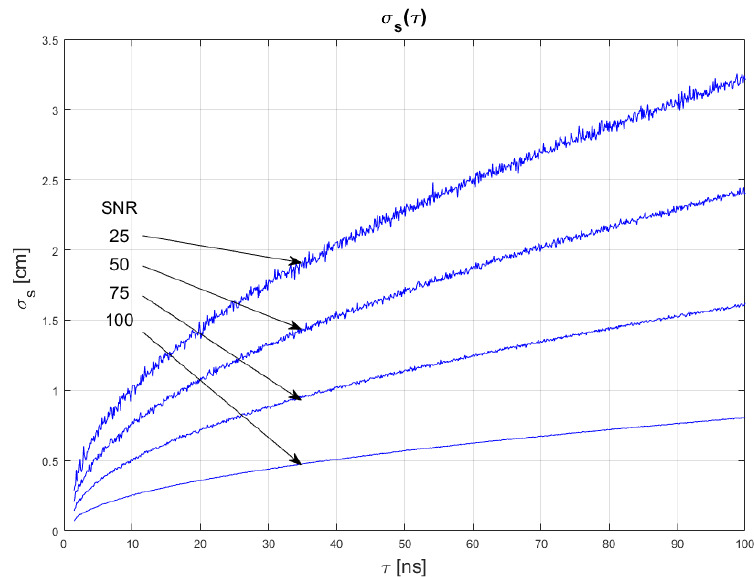
Figure 9. Dependence of measurement uncertainty on pulse width τ for f smp = 1 GHz. Parameters of generated pulses are shown in Table 3 Block 6.